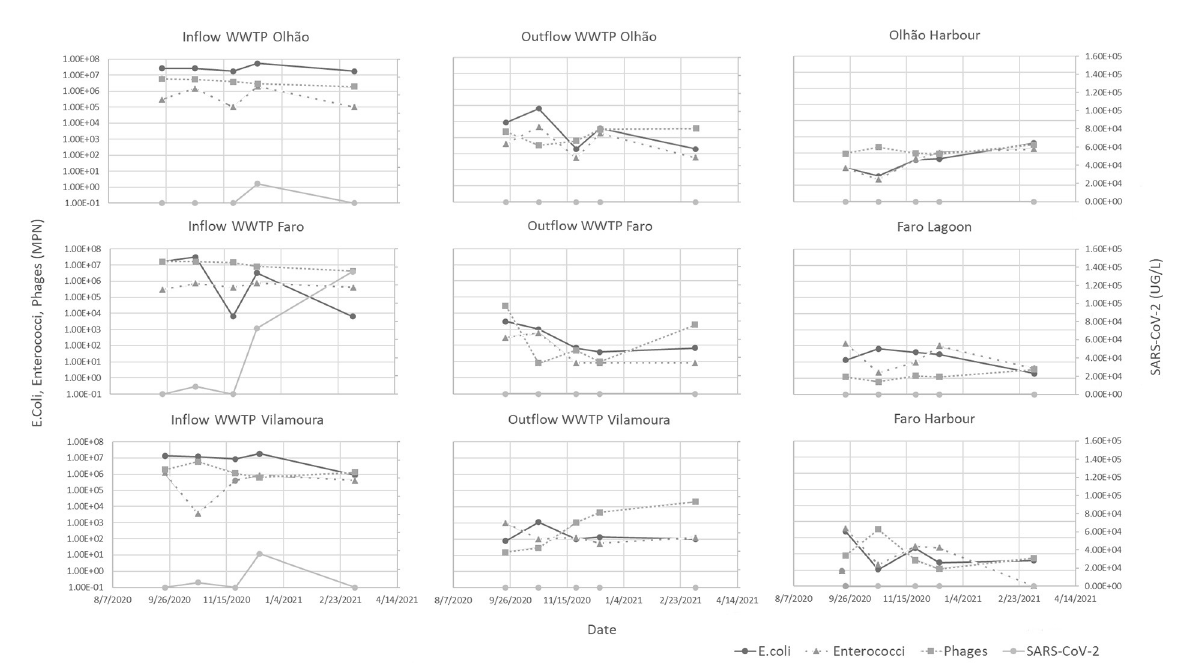
FIGURE2 Escheria coli, Enterococci (MPN per 100mL), somatic coliphage abundances (Plaque Forming Units per 100mL) and SARS-CoV-2 genomic copies ( µ g. L − 1 ) on 5 sampling dates (22/09, 21/10, 23/11 and 14/12 in 2020; 08/03 in 2021) at 3 Ria Formosa stations (Faro lagoon, Faro harbor/dock and Olhão harbor/dock) and 3 WWTP (inflow and outflow) at Vilamoura, Faro airport and